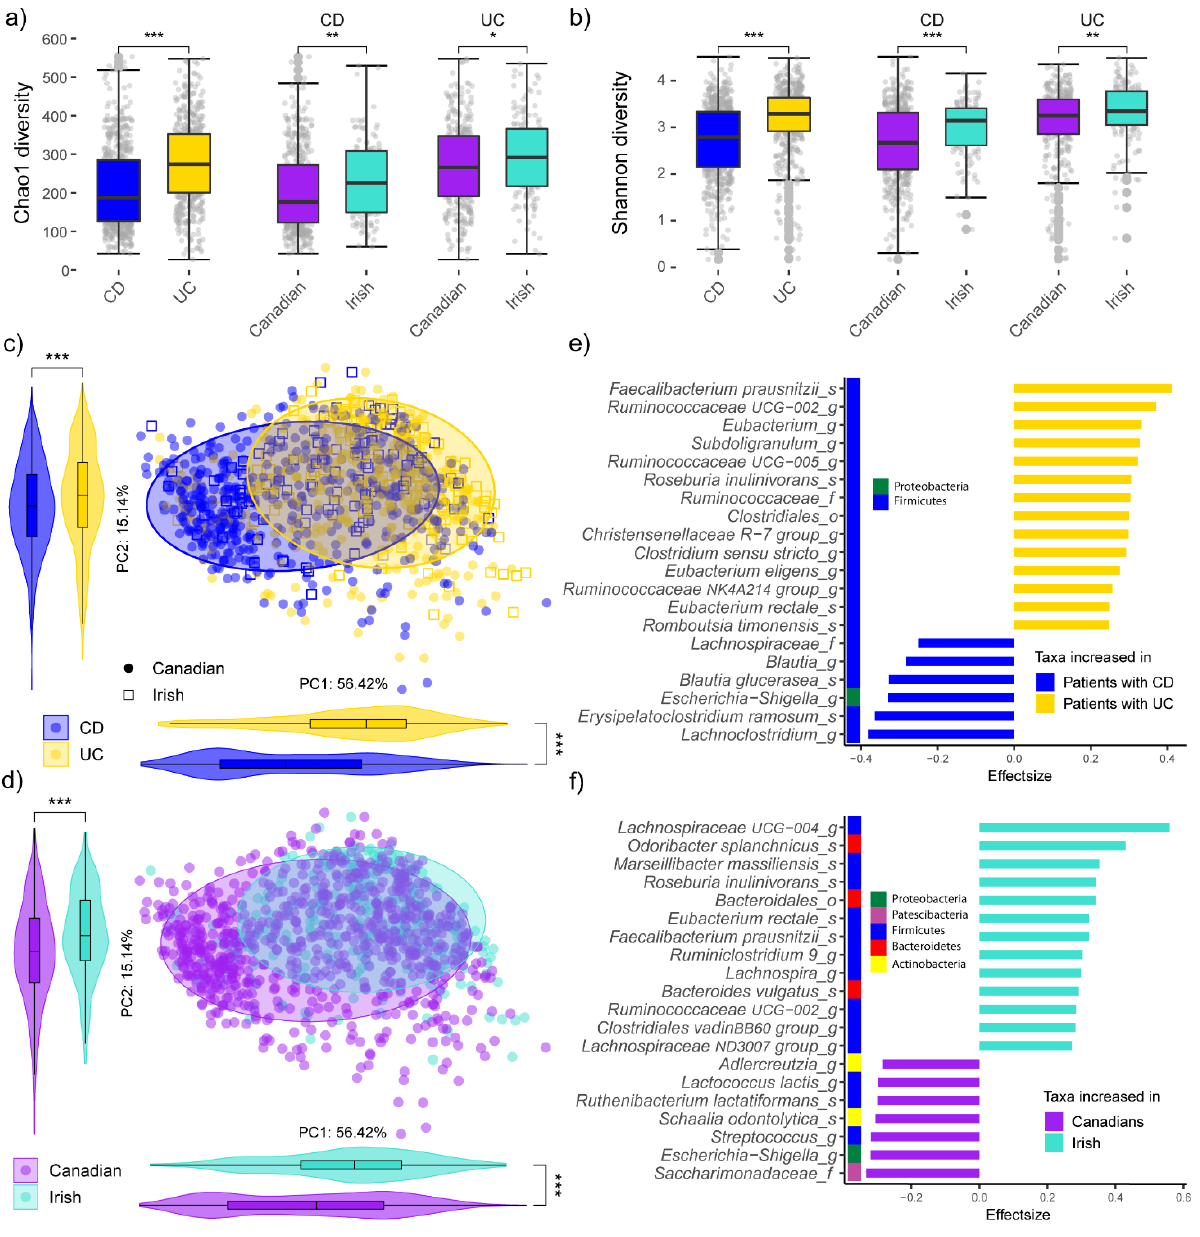
Figure 2. Comparison of ( a ) Chao1 (species richness) and ( b ) Shannon diversity (species richness and evenness) between different IBD-subtypes and geographic location. Principal component analysis (PCA) based on Aitchison distances on all operational taxonomic units (OTUs) present in >10% of samples, with samples grouped by: ( c ) IBD-subtype; and ( d ) geographic location. Violin plots show projections of the PCA points onto PC1 and PC2. Stars show significant differences between the groups as determined by Wilcoxon test. The top 20 most differential OTU abundances between ( e ) IBD-subtypes; and ( f ) geographic location calculated with ALDEx2; * p < 0.05; ** p < 0.01; *** p <